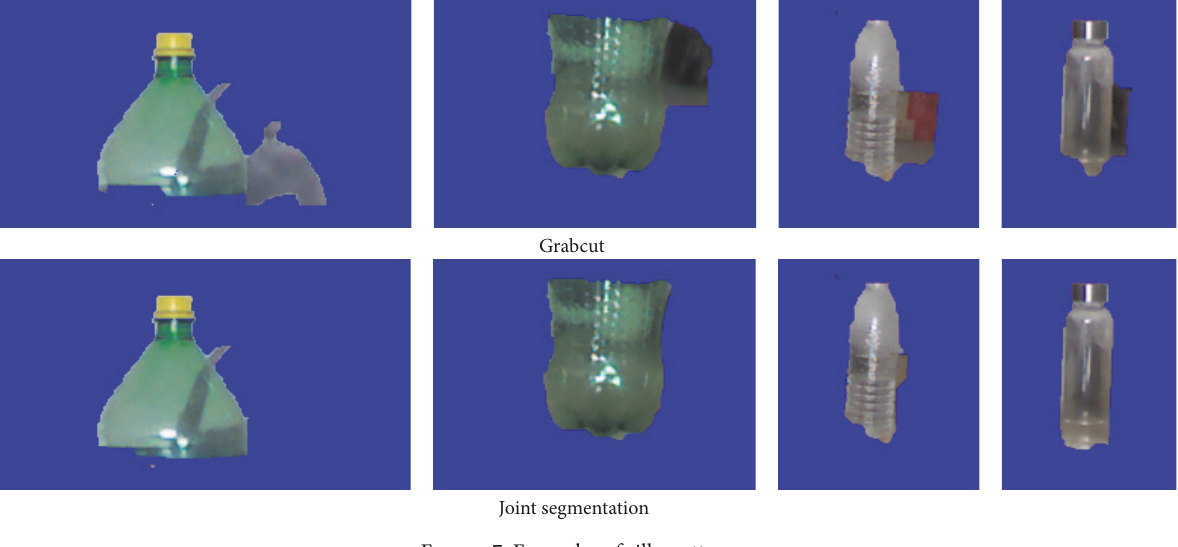
Figure 7: Examples of silhouettes.